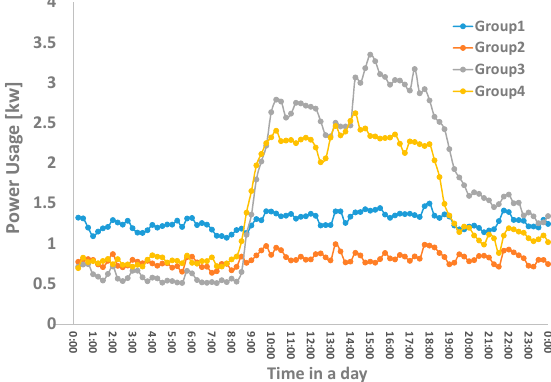
Figure 11. Representative load patterns from each group classified by k-means classification.